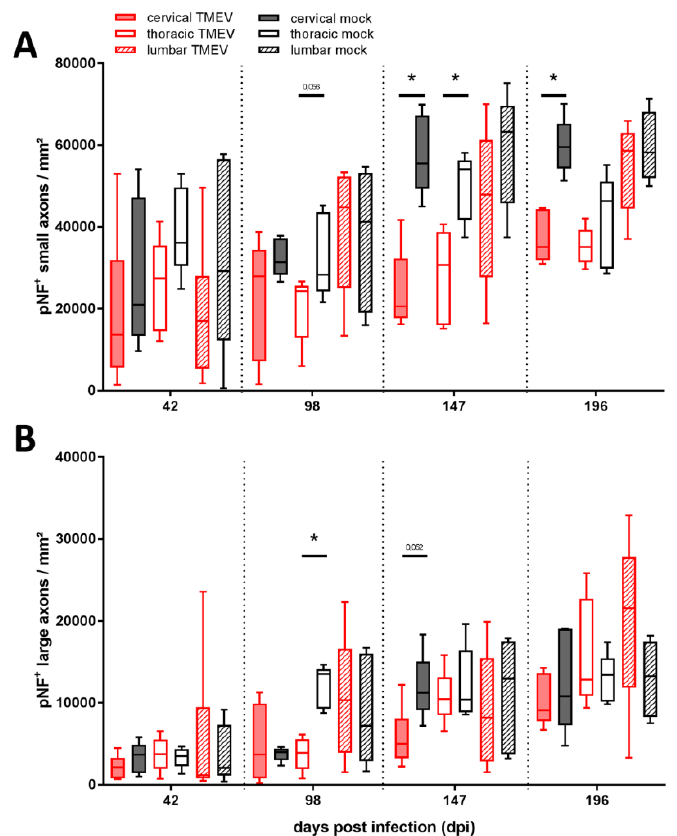
Figure 4. Evaluation of axonal loss showed a decreased number of phosphorylated neurofilaments (pNF) positive small (1 – <4 μm) diameter axons within the thoracic and cervical spinal cord at 147 dpi and within the cervical segment at 196 dpi ( A ). Large (≥4 μm) axons were significantly decreased within the thoracic segment at 98 dpi ( B ). No significant differences between TMEV-infected groups comparing 147 and 196 dpi were detected. Graphs display box and whisker plots. Significant differences between groups detected by Mann–Whitney U-test were indicated by asterisks (* p ≤ 0.05).